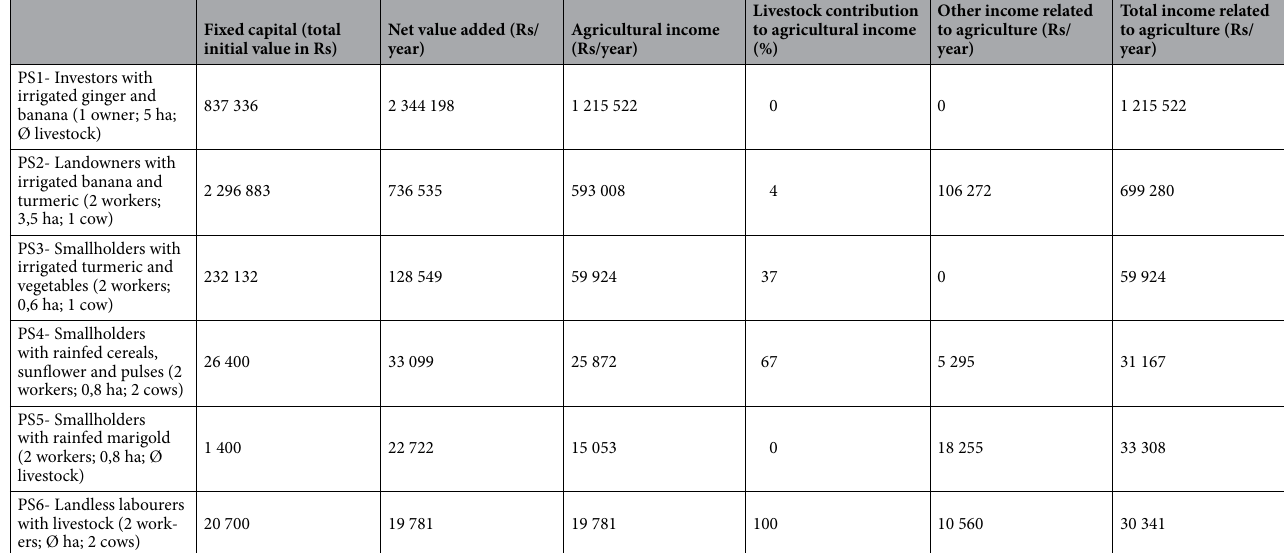
Table 2. Comparison of production systems: fixed capital, net value added and incomes. All indicators in Indian Rupees (Rs) per family worker or per owner. Exchange rate with US Dollar (USD) was 1 USD = 67.5